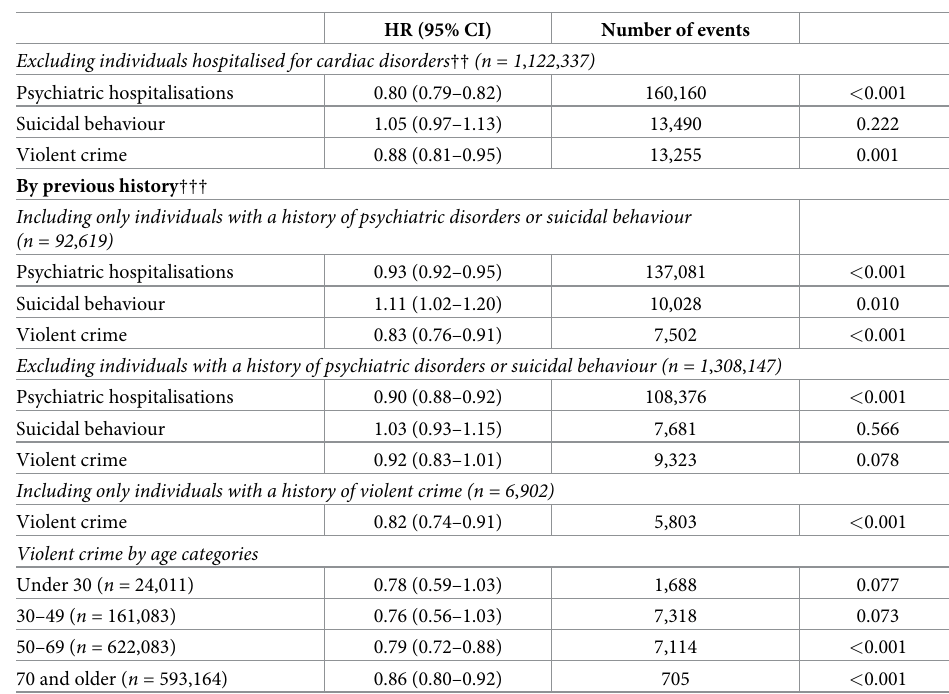
95% CI: 1.12 to 1.17, p < 0.001) and suicidal behaviour (HR: 1.20, 95% CI: 1.05 to 1.36,